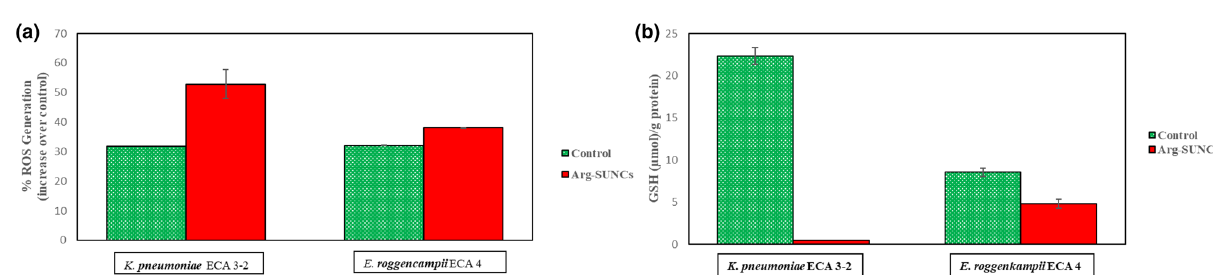
Figure 5. Analysis of the intracellular stress response to exposure from Arg-SUNCs in cell untreated (green-control), treated (red) with 5 ppm of Arg-SUNCs. ( a ) Increase indicate oxidative damage (ROS). ( b ) Intracellular glutathione levels (GSH). The data represents the average standard